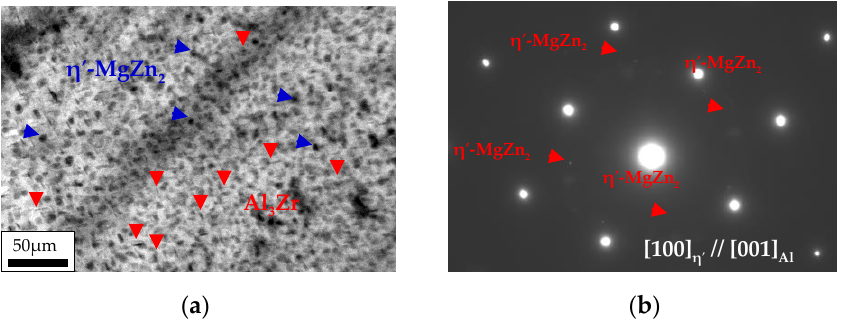
Figure 12. BF TEM image ( a ) of the specimen after treat with path V (hot deformation at 460 °C by 60% + aging at 120 °C for 10 h) and the corresponding SADPs ( b ).